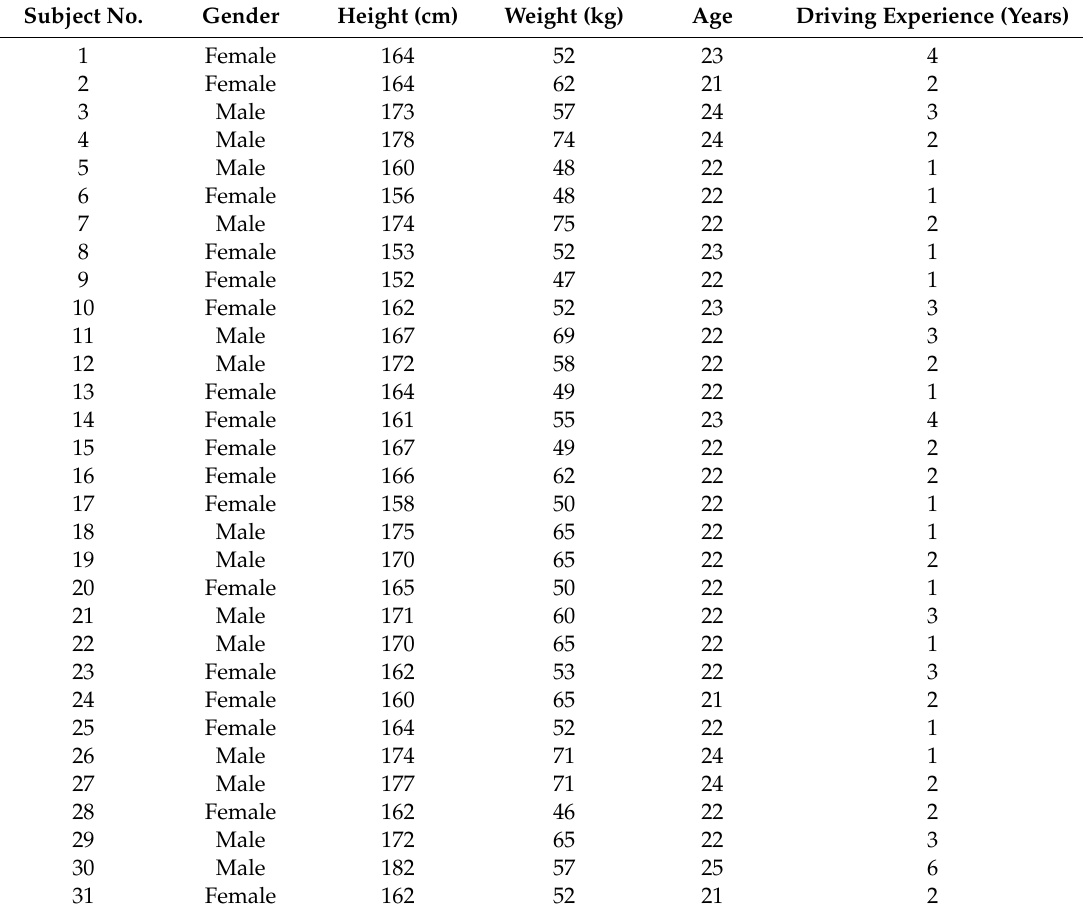
Table 1. Pre-test subjects’ demographic